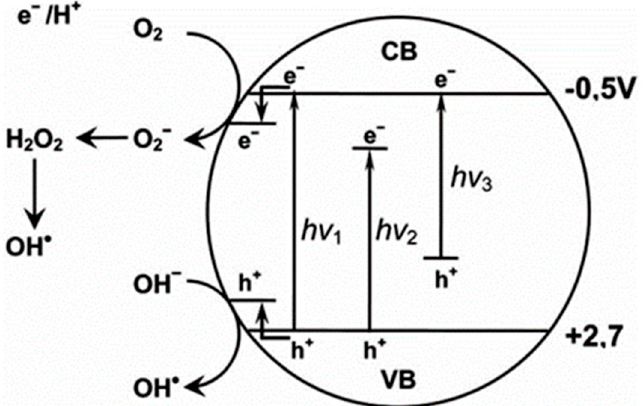
Figure 6. Representative scheme of photocatalysis process of TiO 2 . h ν 1 : pristine TiO 2 ; h ν 2 : metal- doped TiO 2 ; and h ν 3 : nonmetaldoped TiO 2 [65]. Reproduced with permission from Eureka Science (FZC), 2022.